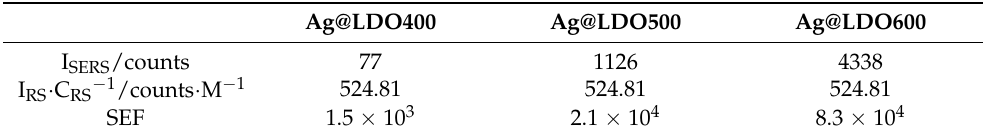
Table 1. Evaluation of substrate enhancement factors in Ag@LDO. Raman signal intensity corre- sponding to the ν CC (C–C stretching) of 4-NTP was selected for calculation. The concentration of 4-NTP at non-SERS and SERS conditions was 5.0 × 10 − 2 and 1.0 × 10 − 4 M, respectively.